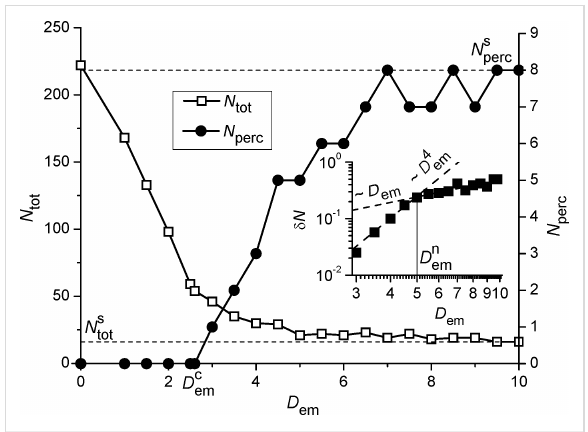
Figure 7: Dependencies of the total amount of adsorbate clusters N tot and number of percolating clusters N perc on the electrical field strength D em at k ∥ = 0.1 and α = 0.06. The inset shows a dependence of the ratio δ N = N perc / N tot on the electrical field strength D em .